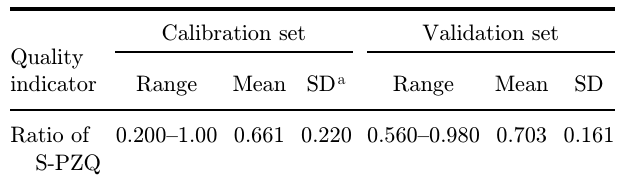
Table 2. The parameters about the ratios in the